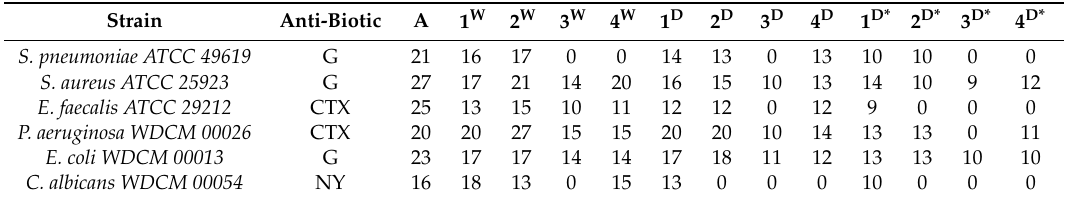
Table 2. Antimicrobial activity of selected antibiotics (A), TCA-AgNP (1), TCA-AgNP-PI (2), Cinn-AgNP (3), Cinn-AgNP-PI (4), and dilutions. ZOI [mm] against microbial strains by agar-well- (W) and disc dilution assay (D). E. faecalis ATCC 29212